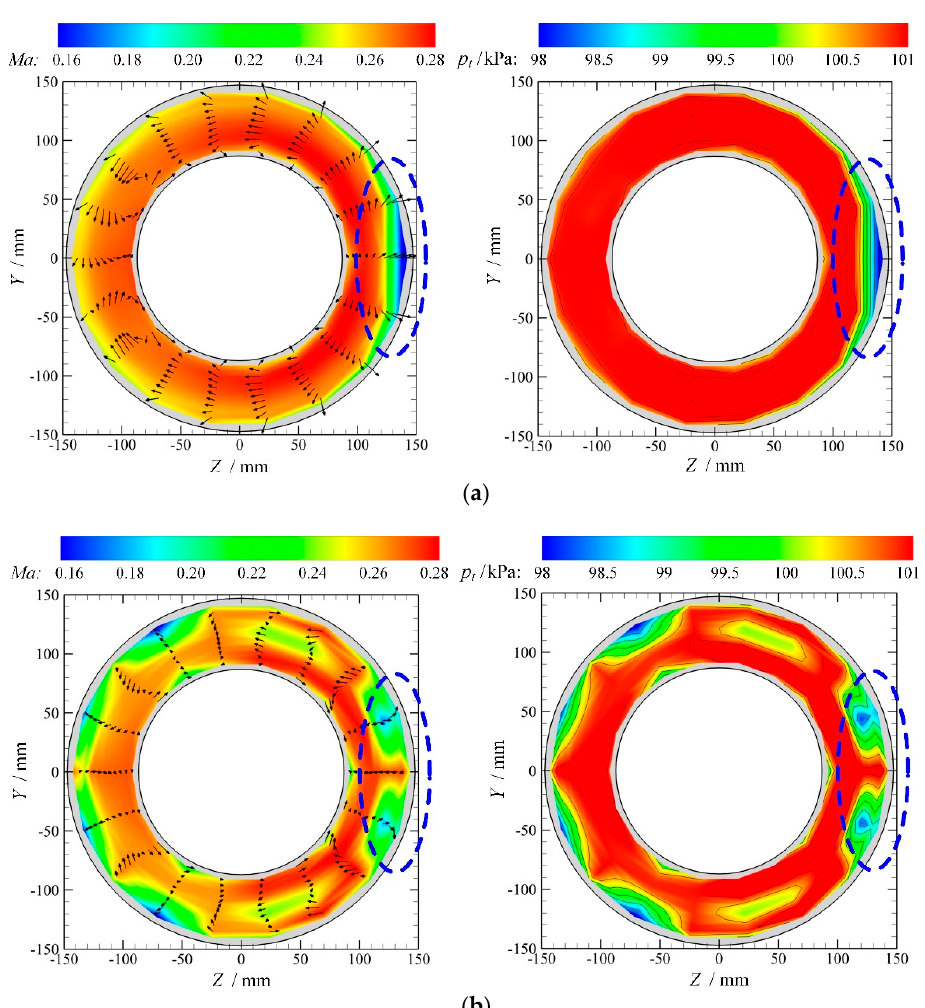
Figure 8. Flow distributions at the exit of the radial inlet chamber ( a ) without guide vanes and ( b ) with guide vanes.